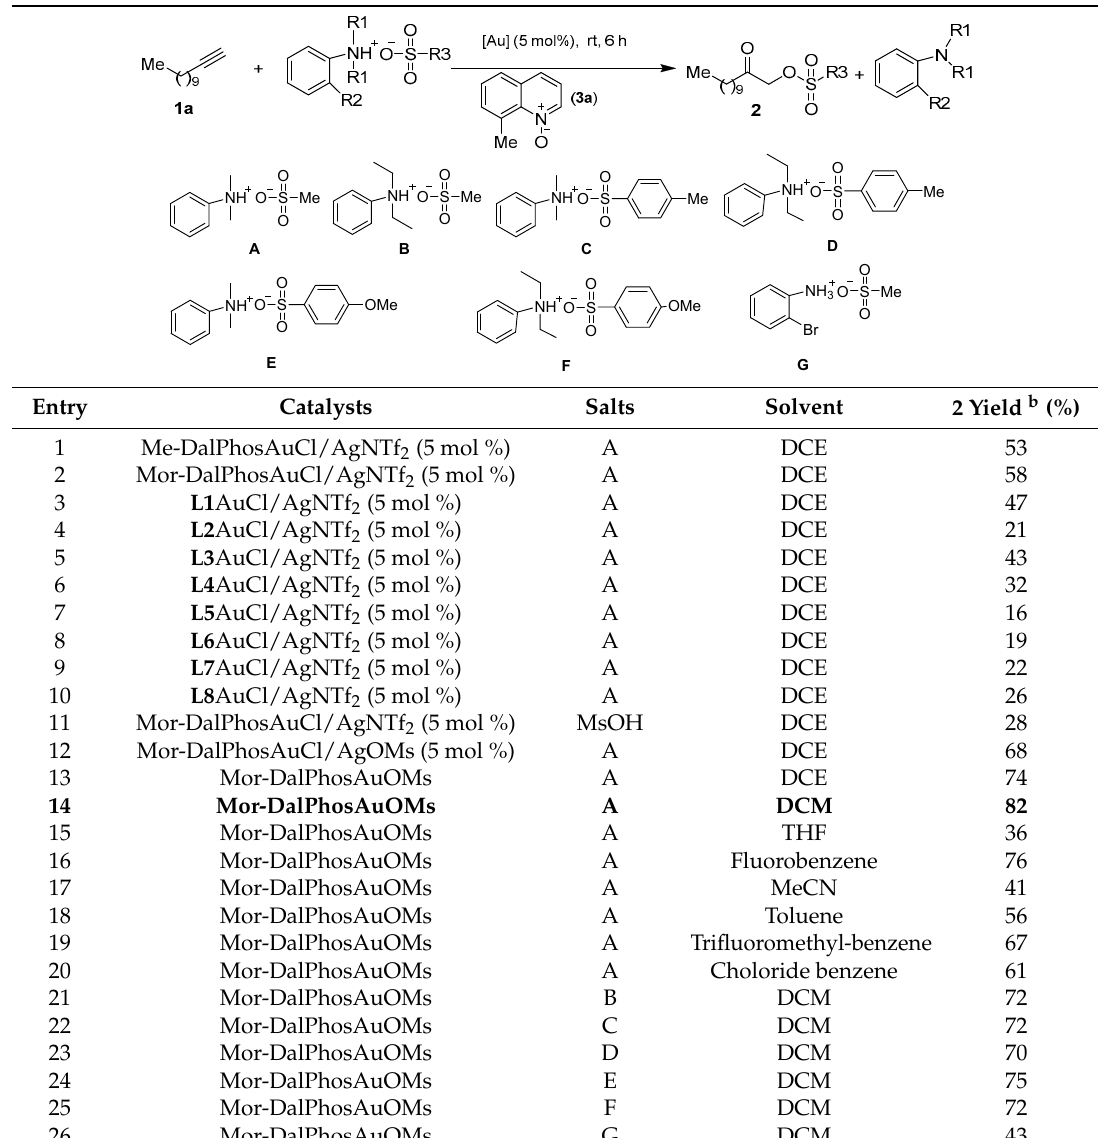
Table 1. Screening gold catalysts, solvents, and ammonium sulfonates a .